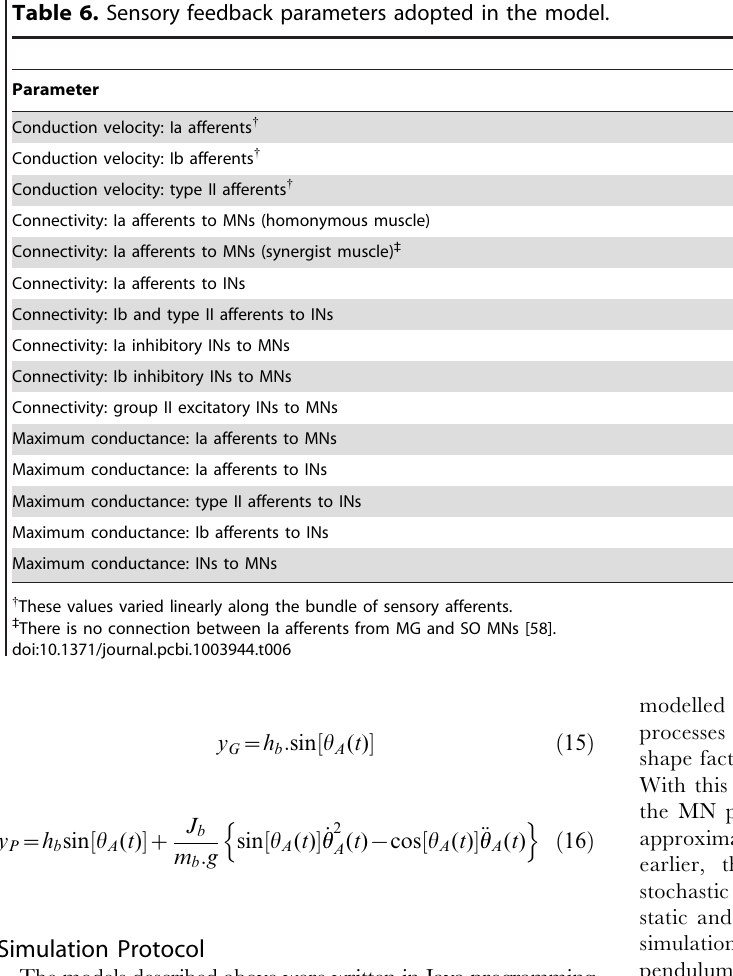
figshare.1027609; Model 2 - http://dx.doi.org/10.6084/m9. figshare.1029084). Analyses were performed on 22.50-s duration